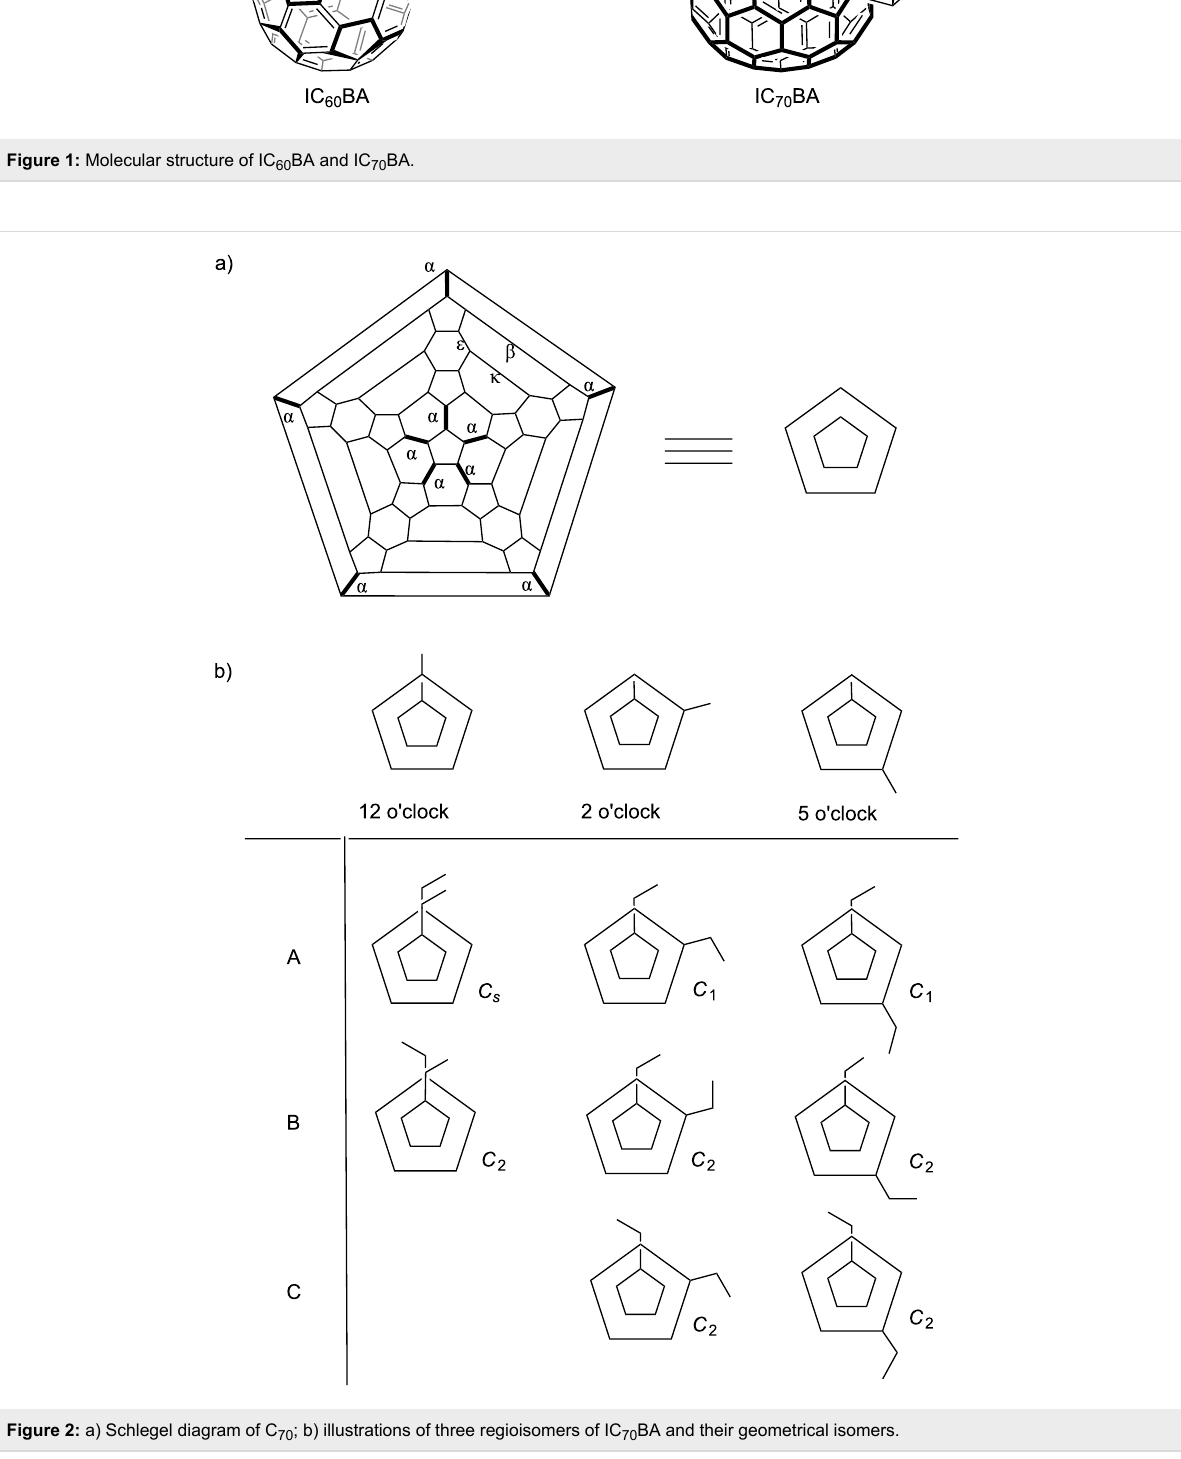
Figure 2: a) Schlegel diagram of C 70 ; b) illustrations of three regioisomers of IC 70 BA and their geometrical